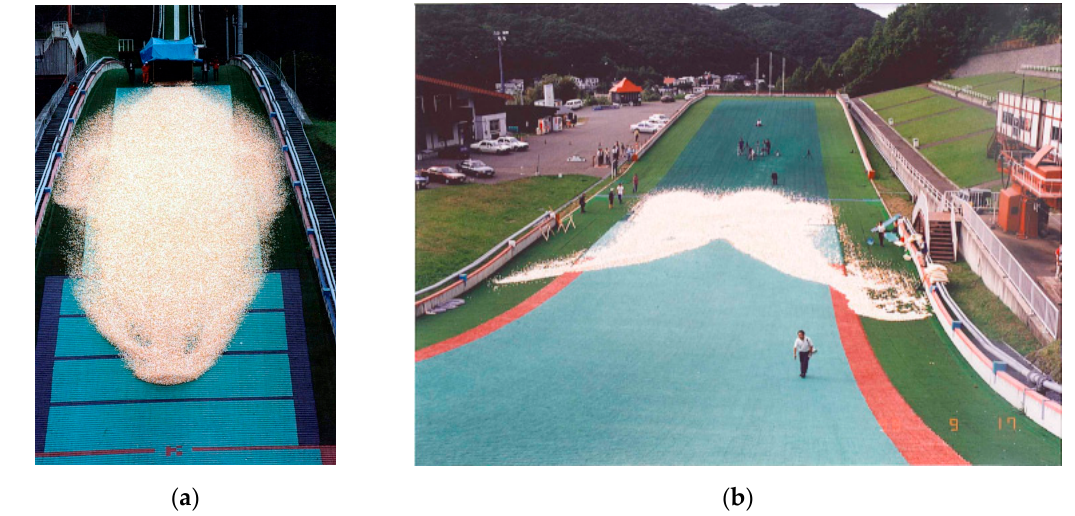
Figure 1. Ping-pong ball granular flow experiments undertaken at the Miyanomori ski jump hill in Hokkaido, Japan [6–8]. ( a ) A ping-pong ball flow shortly after release. ( b ) The final deposit shape of the ping-pong ball flow, which looks like a crescent bending downslope.